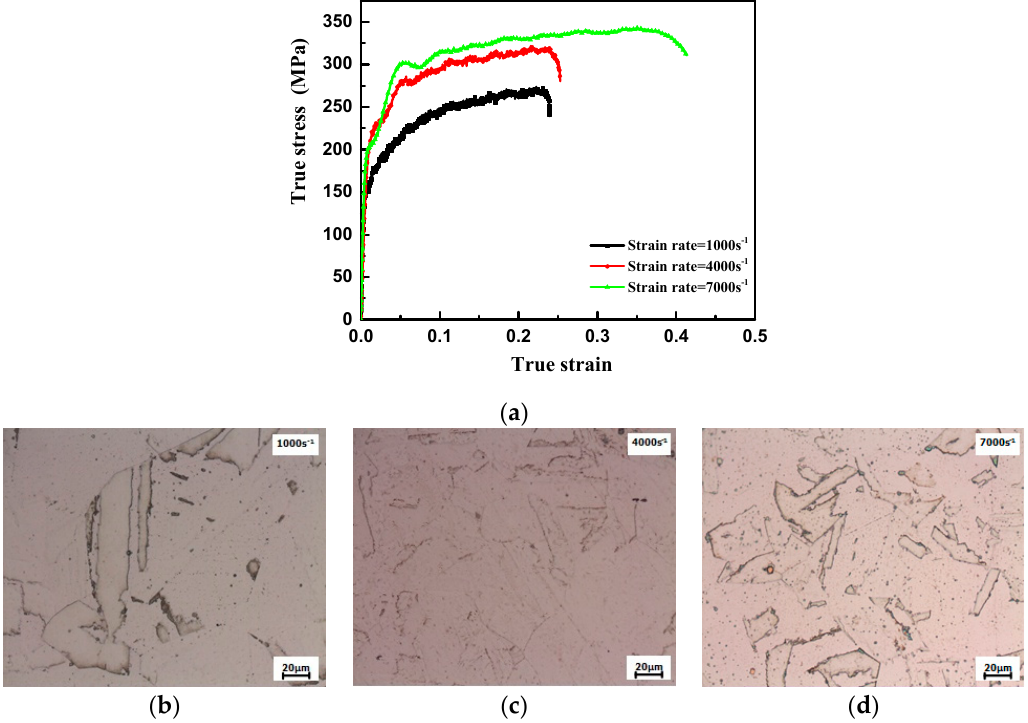
Figure 8. ( a ) True stress–strain curves at 1200 °C; its corresponding optical photomicrographs of SHPB tested samples deformed at ( b ) 1000 s − 1 ; ( c ) 4000 s − 1 and ( d ) 7000 s − 1 .